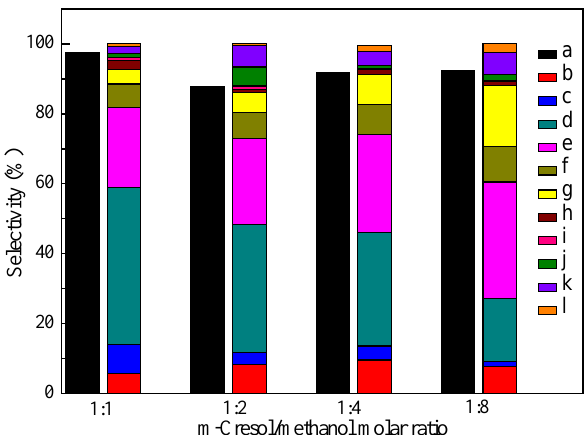
Figure 3. Effect of the m- cresol/methanol molar ratio on the product distribution. a: m- cresol